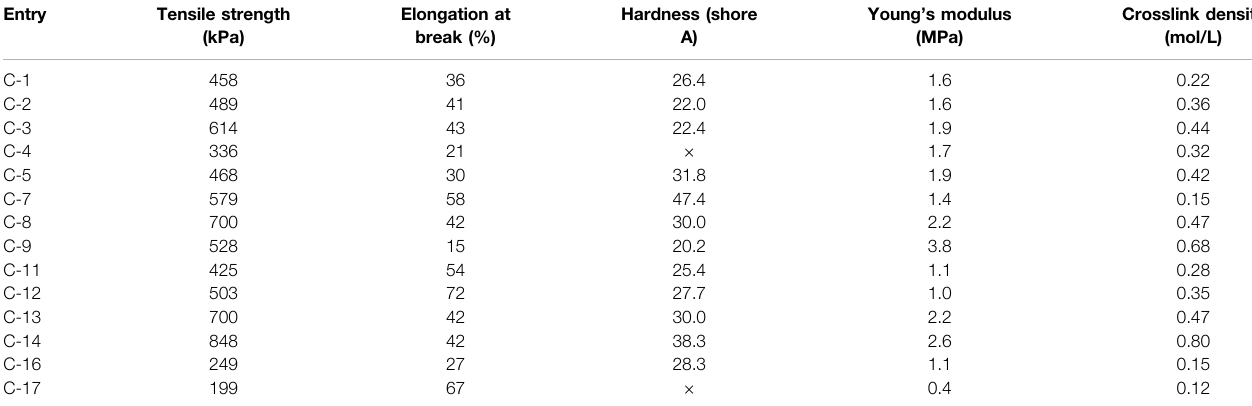
TABLE 3 | Mechanical properties of covalent cross-linked silicone elastomers.